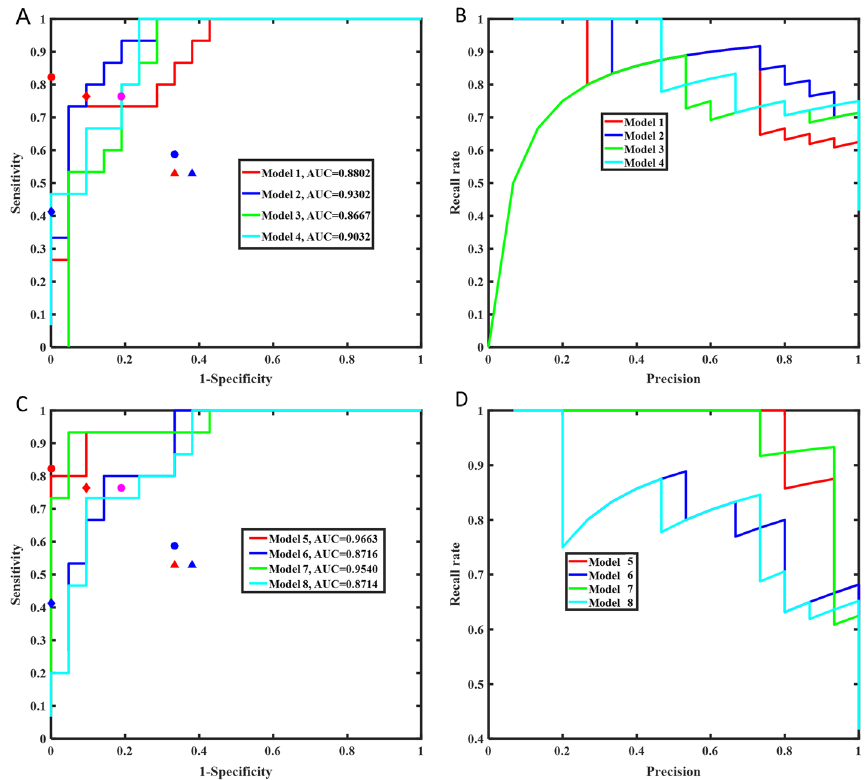
Fig. 5 Performance of models in prospective validation dataset and comparison with human ophthalmologists. A , B Epoch 80. C , D Epoch 60. Model 1: ResNet101; Model 2: ResNet50; Model = = 3: InceptionResNetV2; Model 4: InceptionV3; Model 5: ResNet101; Model 6: ResNet50; Model 7: